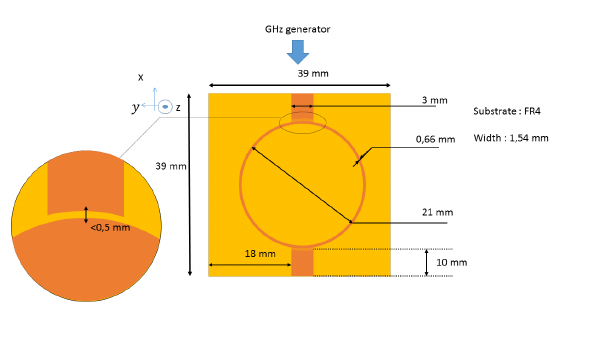
Figure 3: Design of the microstrip ring